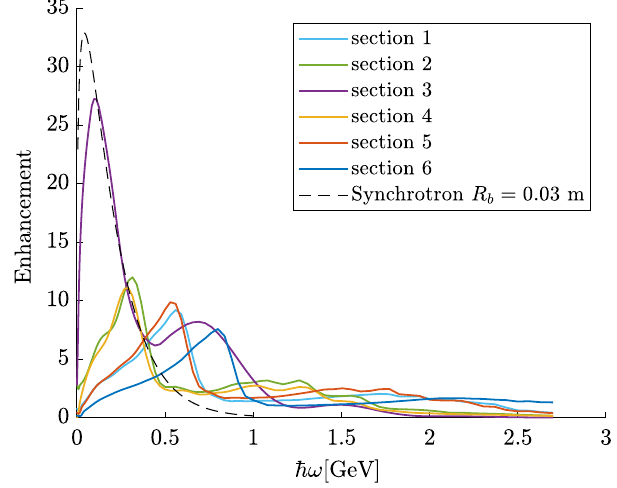
FIG. 4. Radiation spectra from a 12.6 GeV electron hitting the (111) plane of a bent silicon crystal with a bending radius of 0.15 m and an entry angle of 175 μ rad. Here multiple Coulomb scattering is not included. The color of each spectrum pertains to the respective section in Fig. 3 with the same color. The black dashed curve is the synchrotron spectrum for a 12.6 GeVelectron with a characteristic frequency of ℏ ω c ¼ 0 . 3 GeV, which cor- responds to a bending radius of 0.03